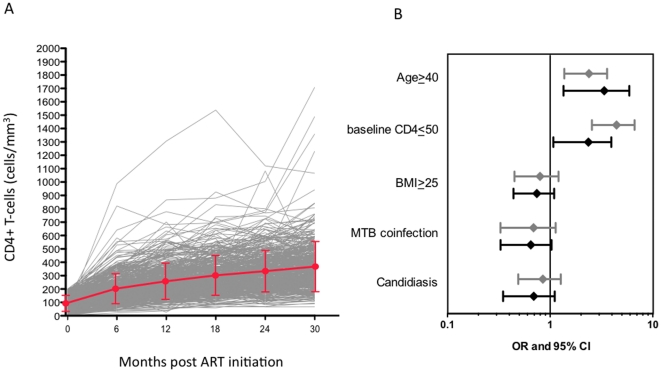
CD4+ T-cell count trajectories and baseline characteristics predicting failure of CD4 cell count recovery.
A. CD4+ T-cell count trajectories for all 442 subjects over the course of 30 months. The red line reflects the median±SEM. B. OR and 95% confidence intervals (CI) for not achieving CD4 counts above 200 cells/mm3 at 12 months (grey) and 500 cells/mm3 at 30 months (black) depending on baseline characteristics. Shown are only factors with significant or close to significant effect in the multivariate model.